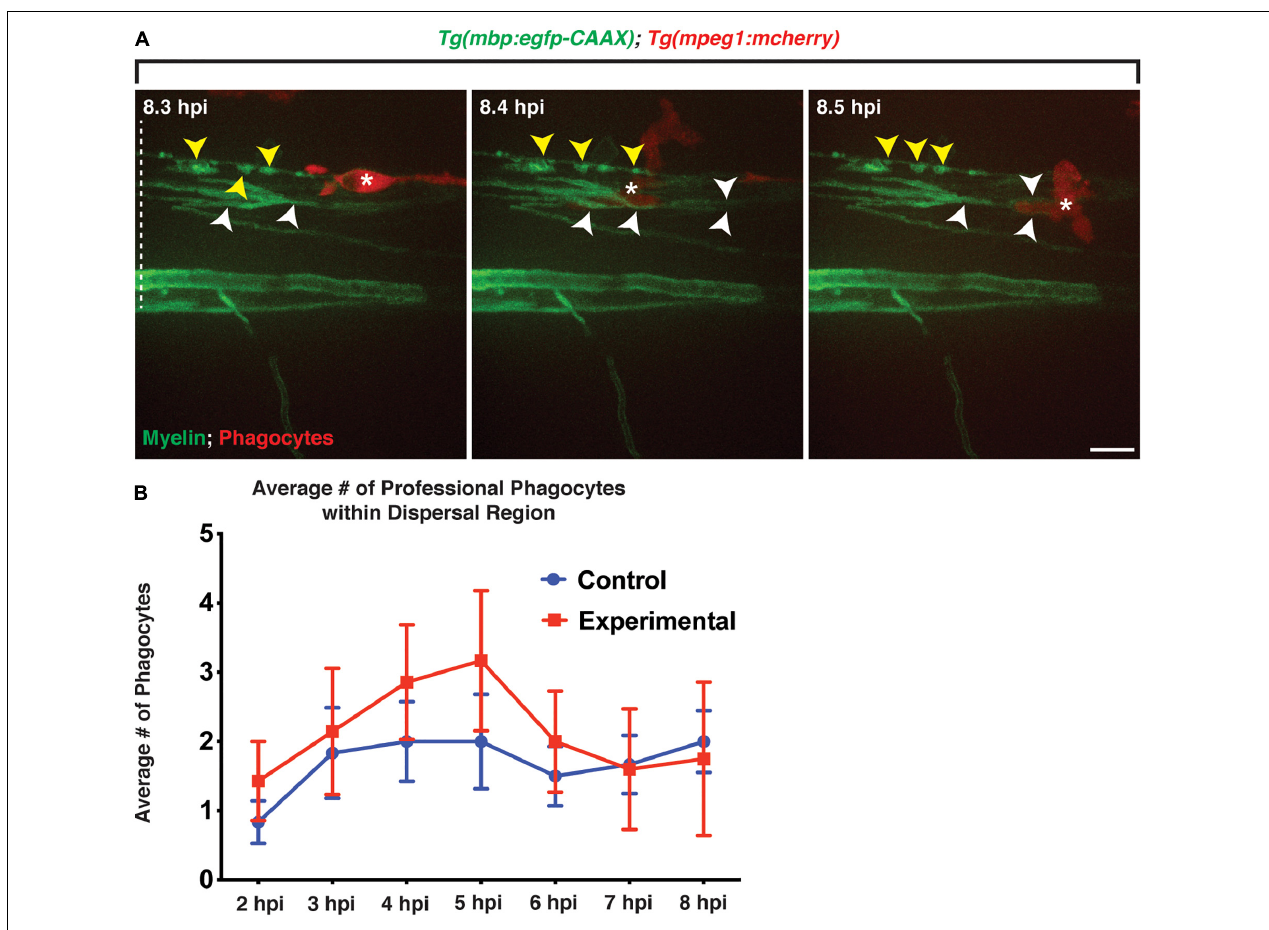
FIGURE 5 | Professional phagocytes traverse through mbp + membrane layers. All images are lateral views of the spinal cord with anterior to the left and dorsal to the top. (A) Following injection of lysolecithin, a mCherry + phagocyte is observed traversing through mbp + membrane layers within the lesion area, physically moving the layers during its migration. White arrowheads identify the layers that are moved by the phagocyte, and yellow arrowheads denote the myelin ovoids. (B) Quantification of the average number of professional phagocytes responding to the lesion following injection of a control (control) solution ( n = 6) or lysolecithin (experimental) ( n = 7); p = 0.0864. White dashed line denotes the spinal cord. Scale bars, 25 µ